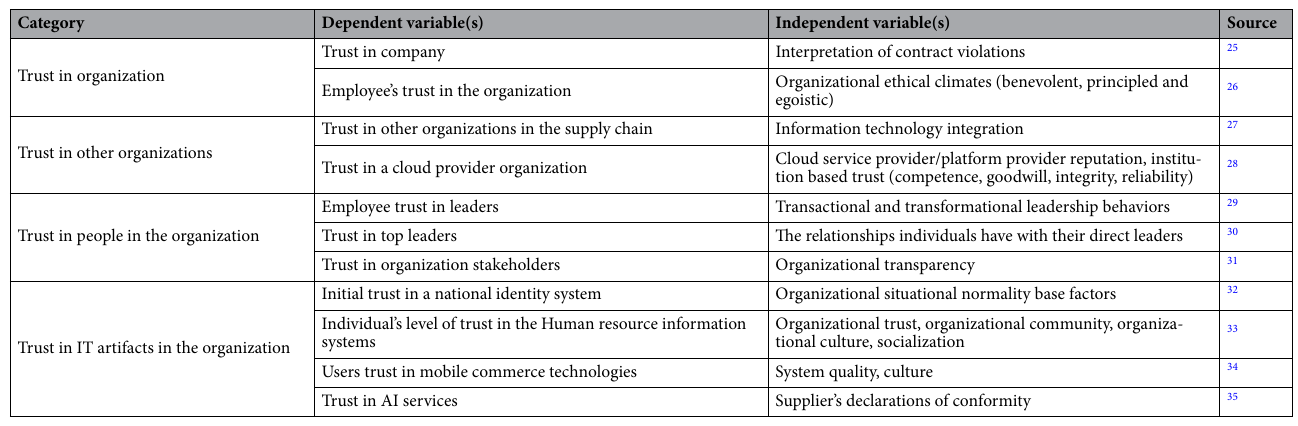
Table 2. Studies on the antecedents of trust in organizational context.